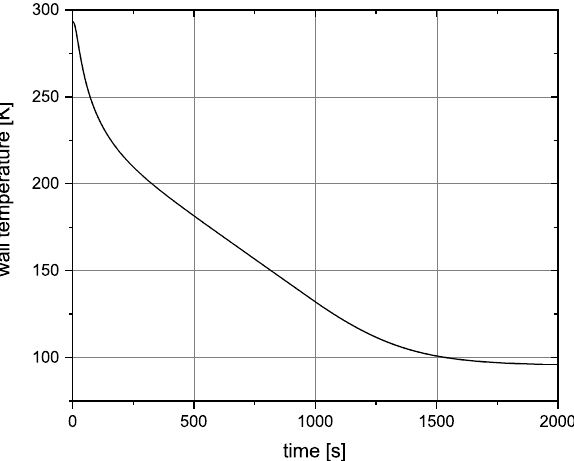
Figure 8. Temperature of the tank wall during the pre-cooling